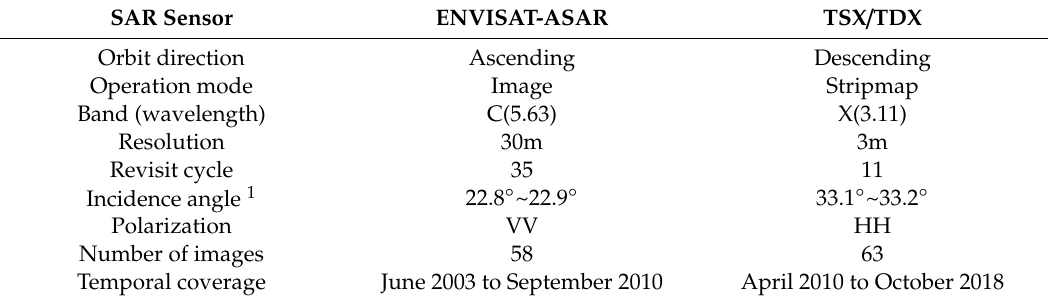
Table 1. Acquisition parameters of the ENVISAT-ASAR and TSX / TDX data sets. SAR Sensor ENVISAT-ASAR TSX /